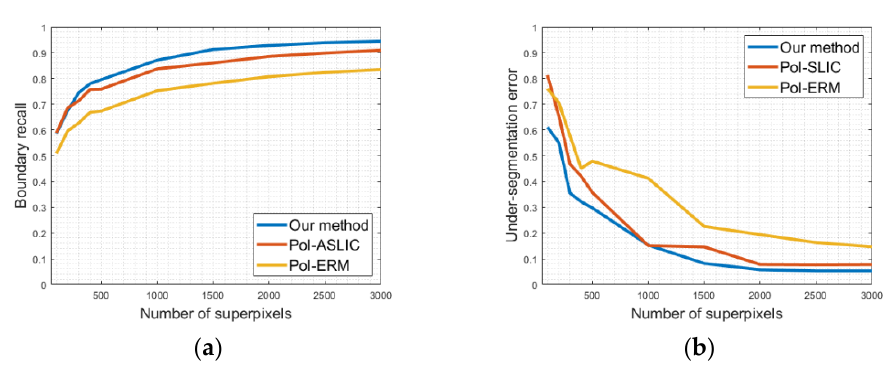
Figure 7. Numerical evaluation of superpixel segmentation performance based on ESAR data. ( a ) Boundary recall; ( b ) under-segmentation error.